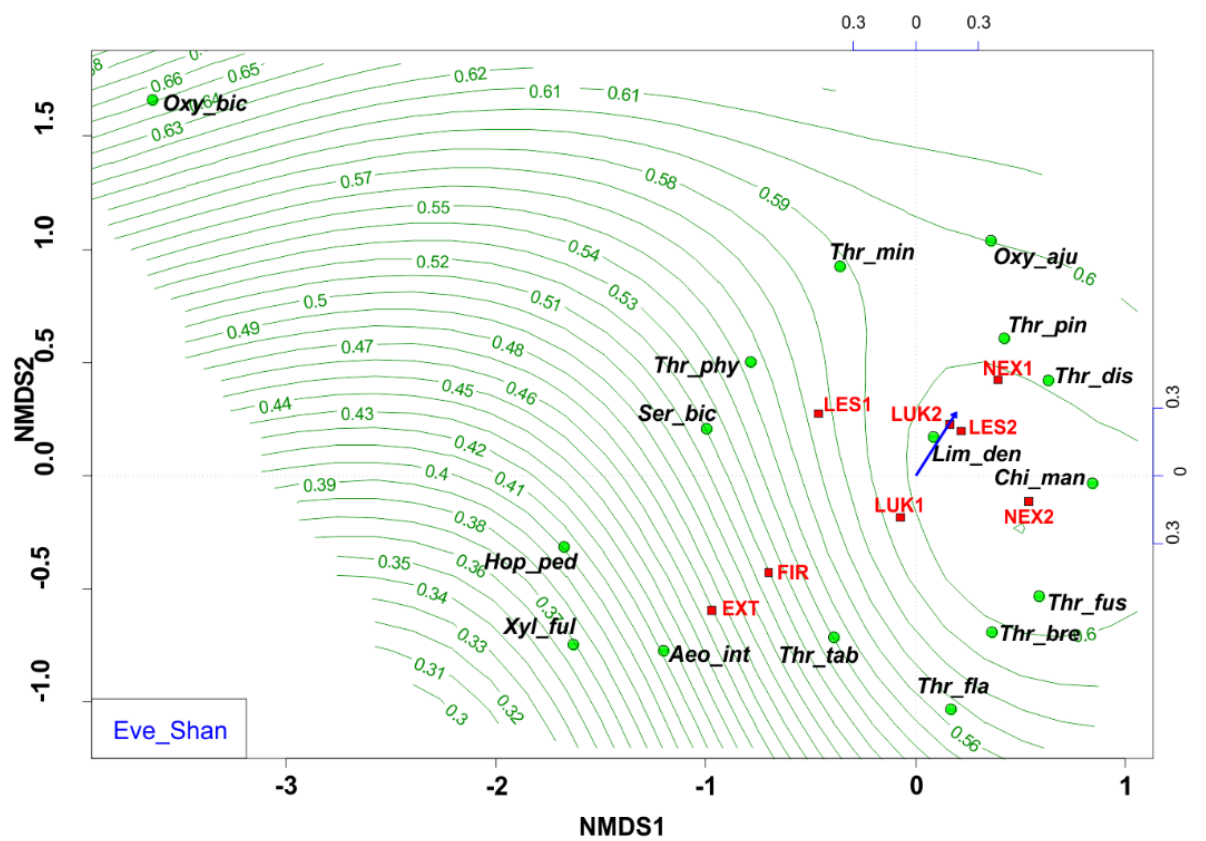
Figure 7. Nonmetric multidimensional scaling (NMDS) plot showing the relatedness of the thrips assemblages between the different samples and study plots (EXT, FIR, NEX1, NEX2, LUK1, LUK2, LES1, LES2) and the Shannon evenness (blue arrow, green contour line). Oxy_bic – Oxythrips bicolor ,